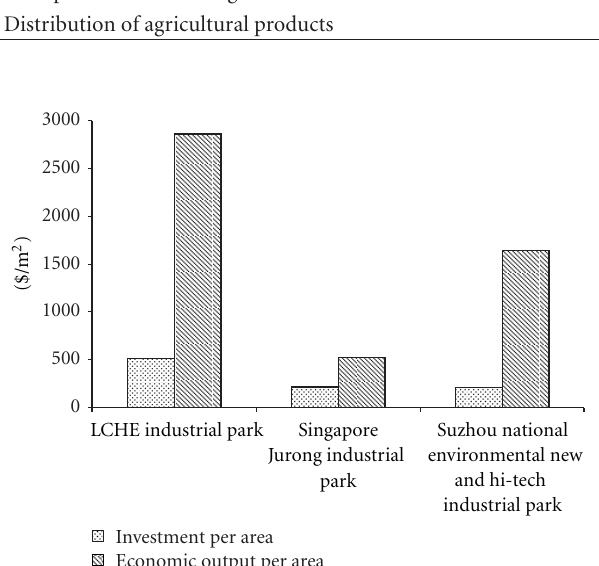
Figure 6: Economic indicators of di ff erent industrial